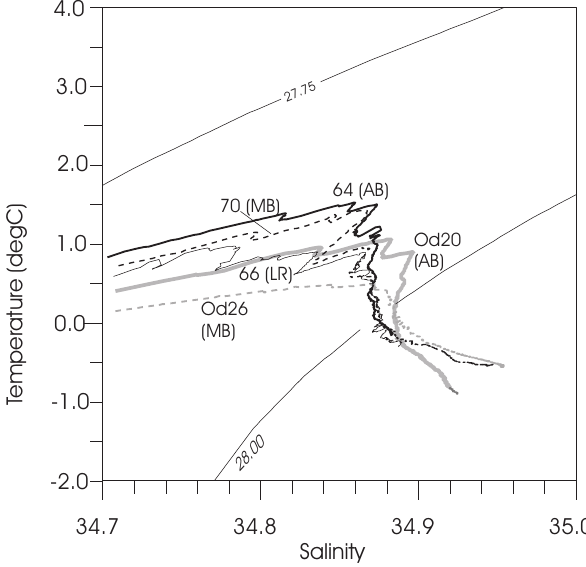
Fig. 9. Temperature vs. salinity at the Lomonosov Ridge from ARKXII 1996 at 86 ◦ N (black) and from Oden 1991 at 88 ◦ N (grey). Oden station 20 is in the Amundsen Basin and Oden station 26 is in the Makarov Basin. Note that the upper part from Polarstern station 70 (Makarov Basin) is similar to that of station 64 (Amund- sen Basin), while the intermediate part of station 66 (Lomonosov Ridge) shows interleaving structures similar to those at station 70 (Makarov